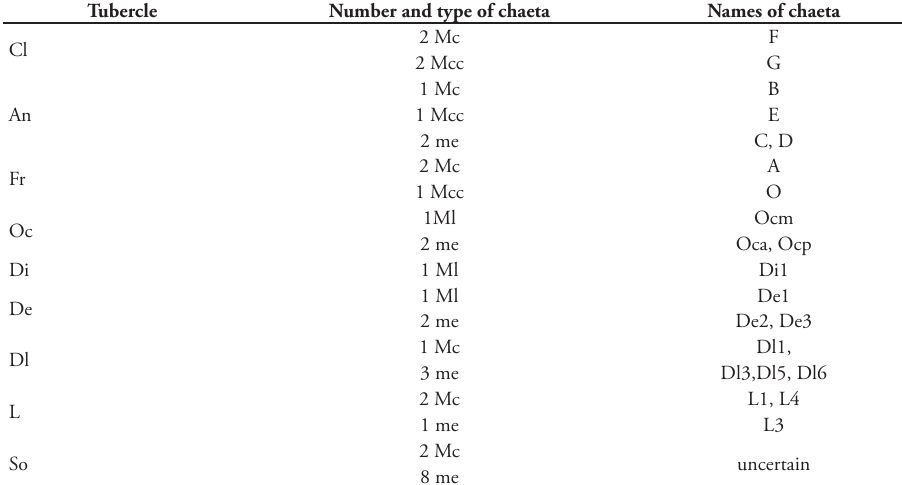
Table 2a. Cephalic tubercles and chaetotaxy of Paralobella tianmuna sp. n.